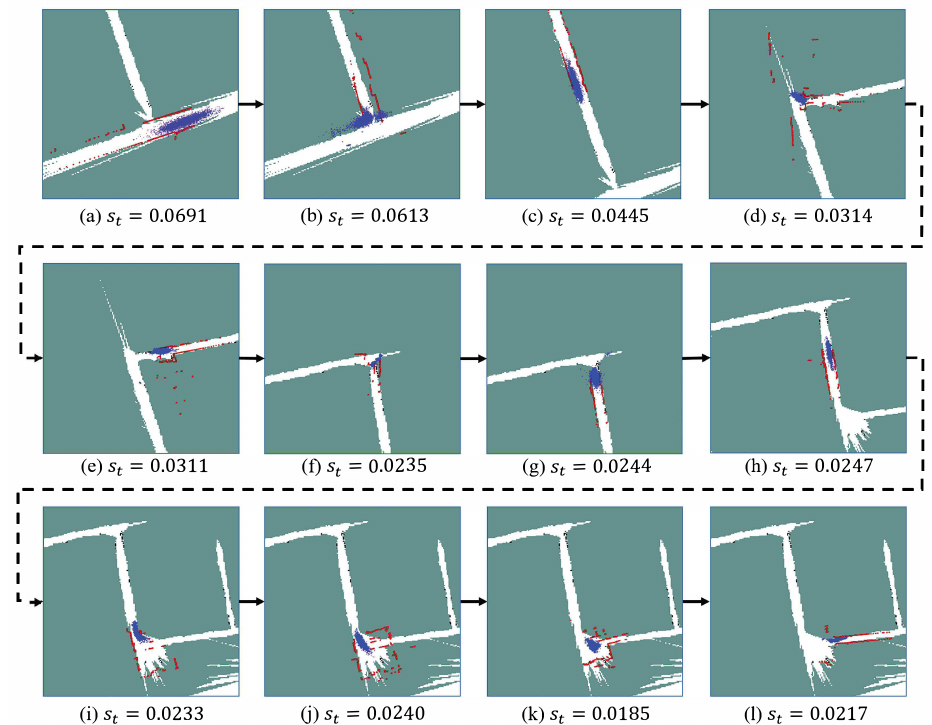
Figure 15. The scale correction for making rescale measurements match the drifted map. Red dots are the laser beams that are rescaled based on the estimated s t . Blue points are the particles employed by the MCL